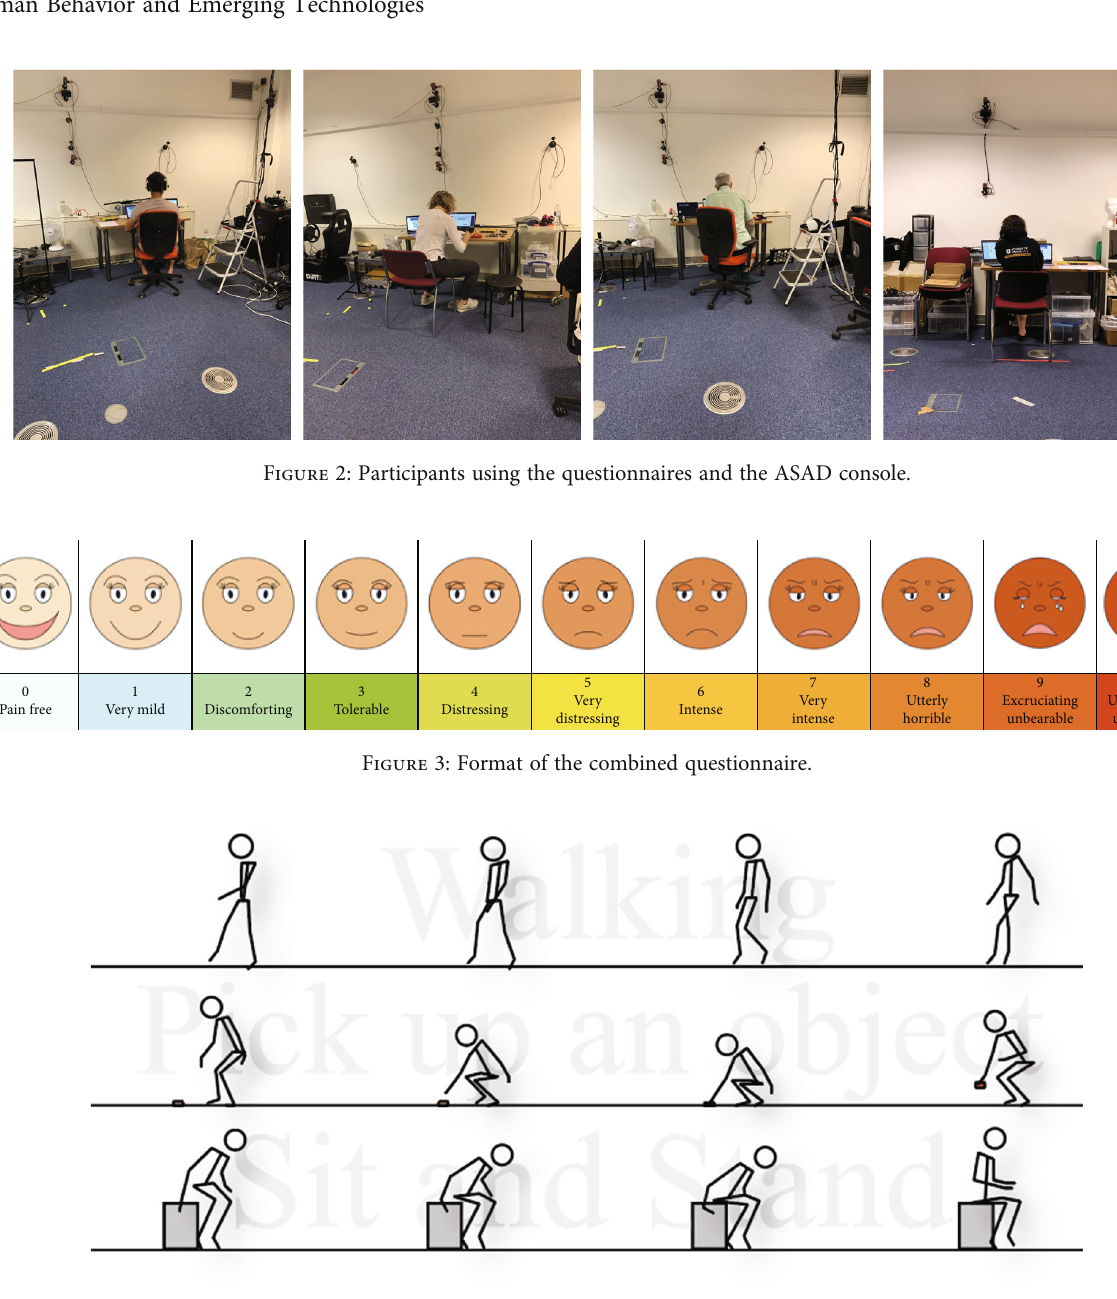
Figure 4: Movements before and after the fatigue test.